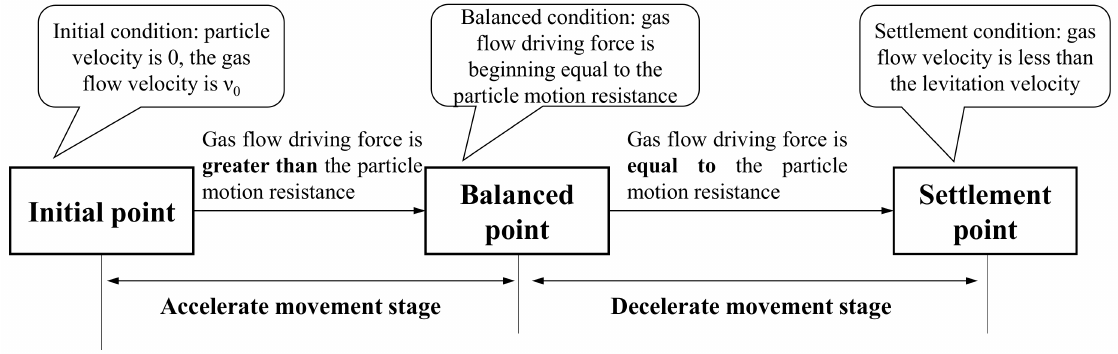
Figure 8. The pulverized coal particles migration